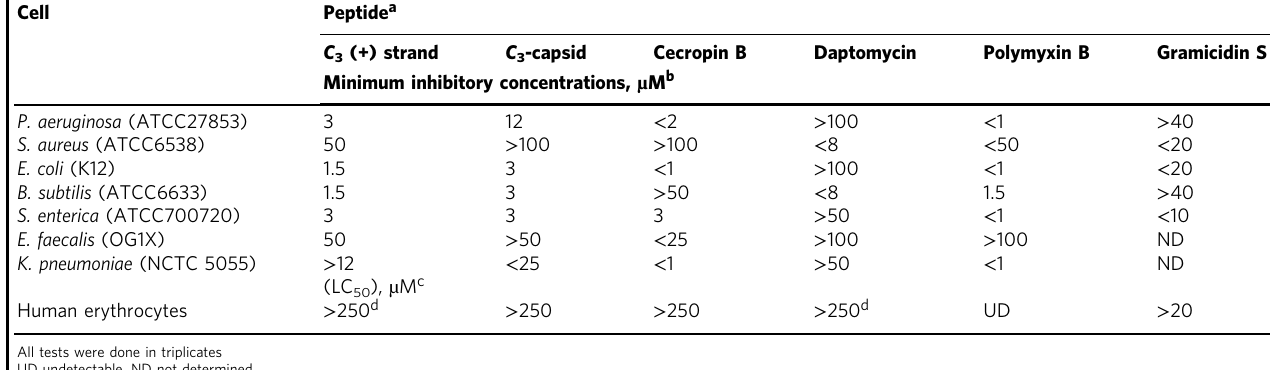
Table 1 Biological activities of peptides used in the study